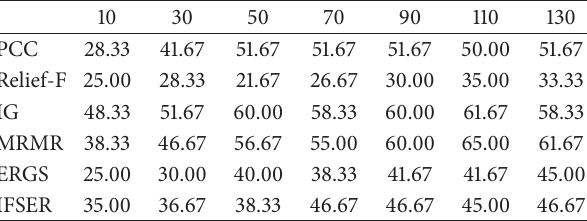
Table 8: Classification accuracies (%) of different feature selection methods with NN on 9 Tumors